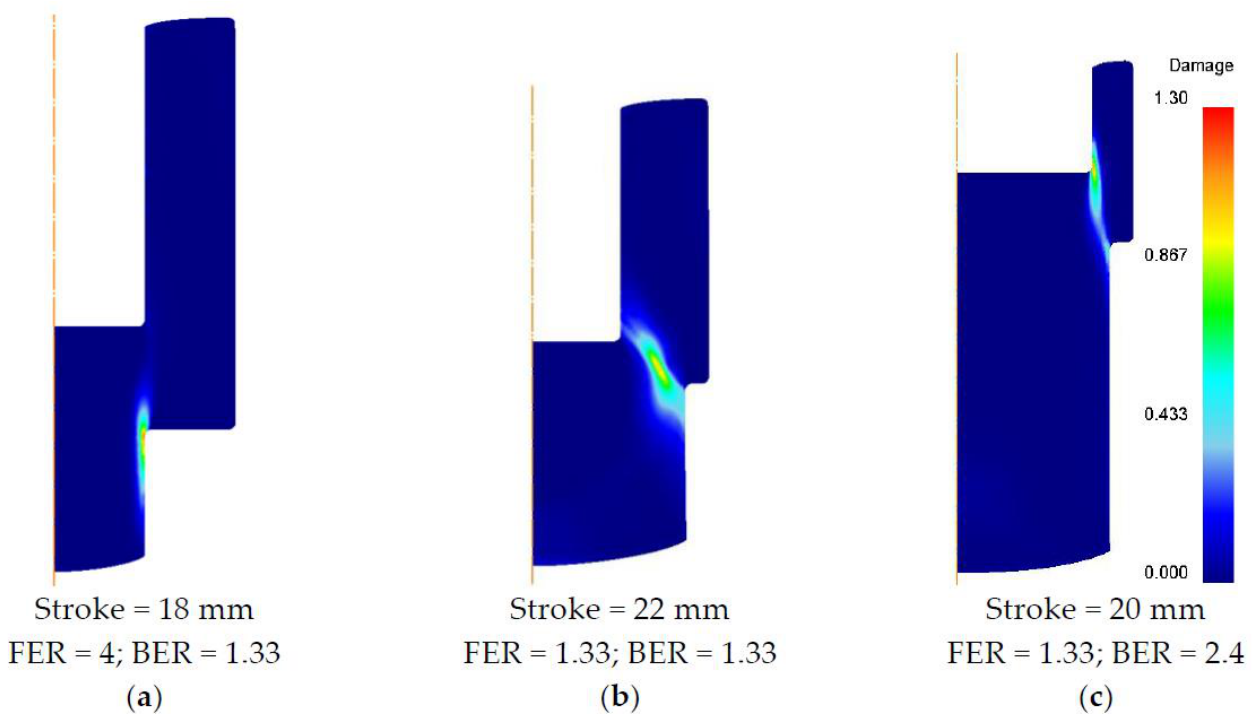
Figure 8. Distribution of the damage values from DEFORM 2D simulation of CFBE experiment: ( a ) FER = 4; BER = 1.33, at stroke 18 mm, ( b ) FER = 1.33; BER = 1.33, at stroke 22 mm, ( c ) FER = 1.33; BER = 2.4, at stroke 20 mm.